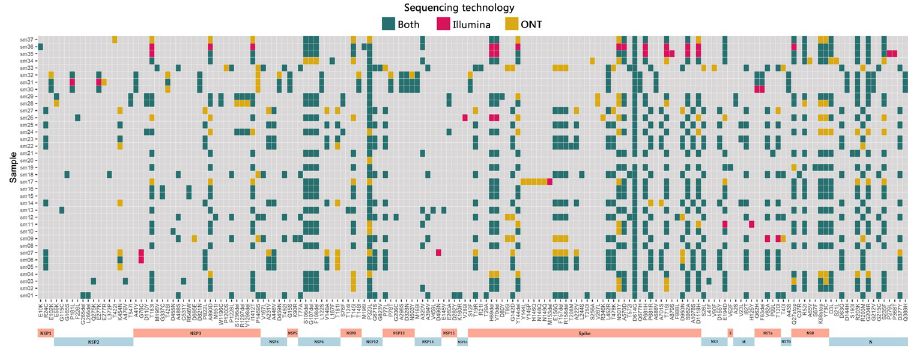
Fig 2. Comparison of amino acid changes detected in SARS-CoV-2 genomes by both sequencing technologies. Annotated amino acid substitutions and deletions detected in each sample (n = 37). Mutations colored in green indicates they are synonymously detected by both sequencing technologies, whereas yellow and red indicate mutations detected exclusively by only one technology. The X axis indicates each amino acid, which is denoted by the original amino acid, its position in the protein and the substitution/deletion. Amino acid deletions are denoted by